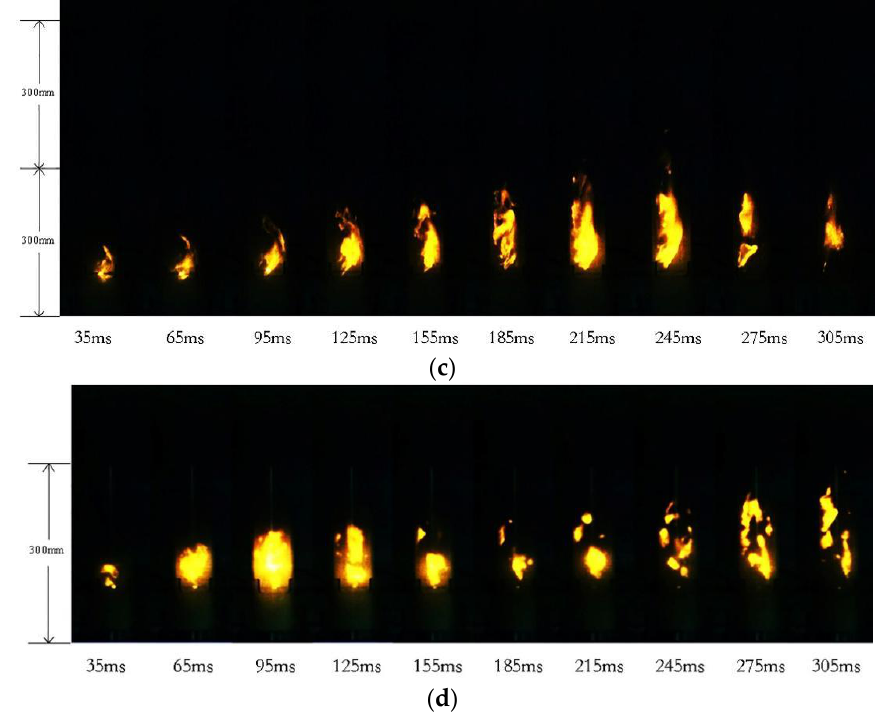
Figure 4. Flame diagram of sucrose dust under different conditions. ( a ) Sucrose dust; ( b ) sucrose dust with 10% NaHCO 3 added at 48–74 μm; ( c ) sucrose dust with 10% NaHCO 3 added at 38–47 μm; ( d ) sucrose dust with 10% NaHCO 3 added at 25–37 μm.